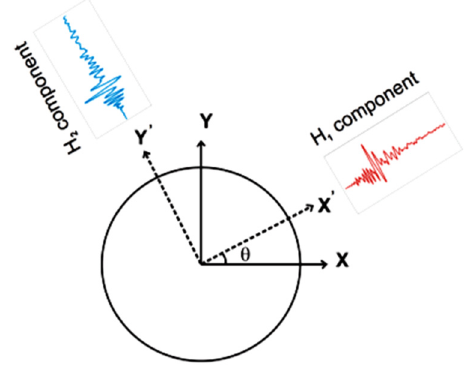
Figure 10. Applying two horizontal components of the records, H 1 and H 2 , along X’ and Y’ axes rotated by θ ° relative to the principal axes of structure, X (longitudinal direction) and Y (trans- verse direction).